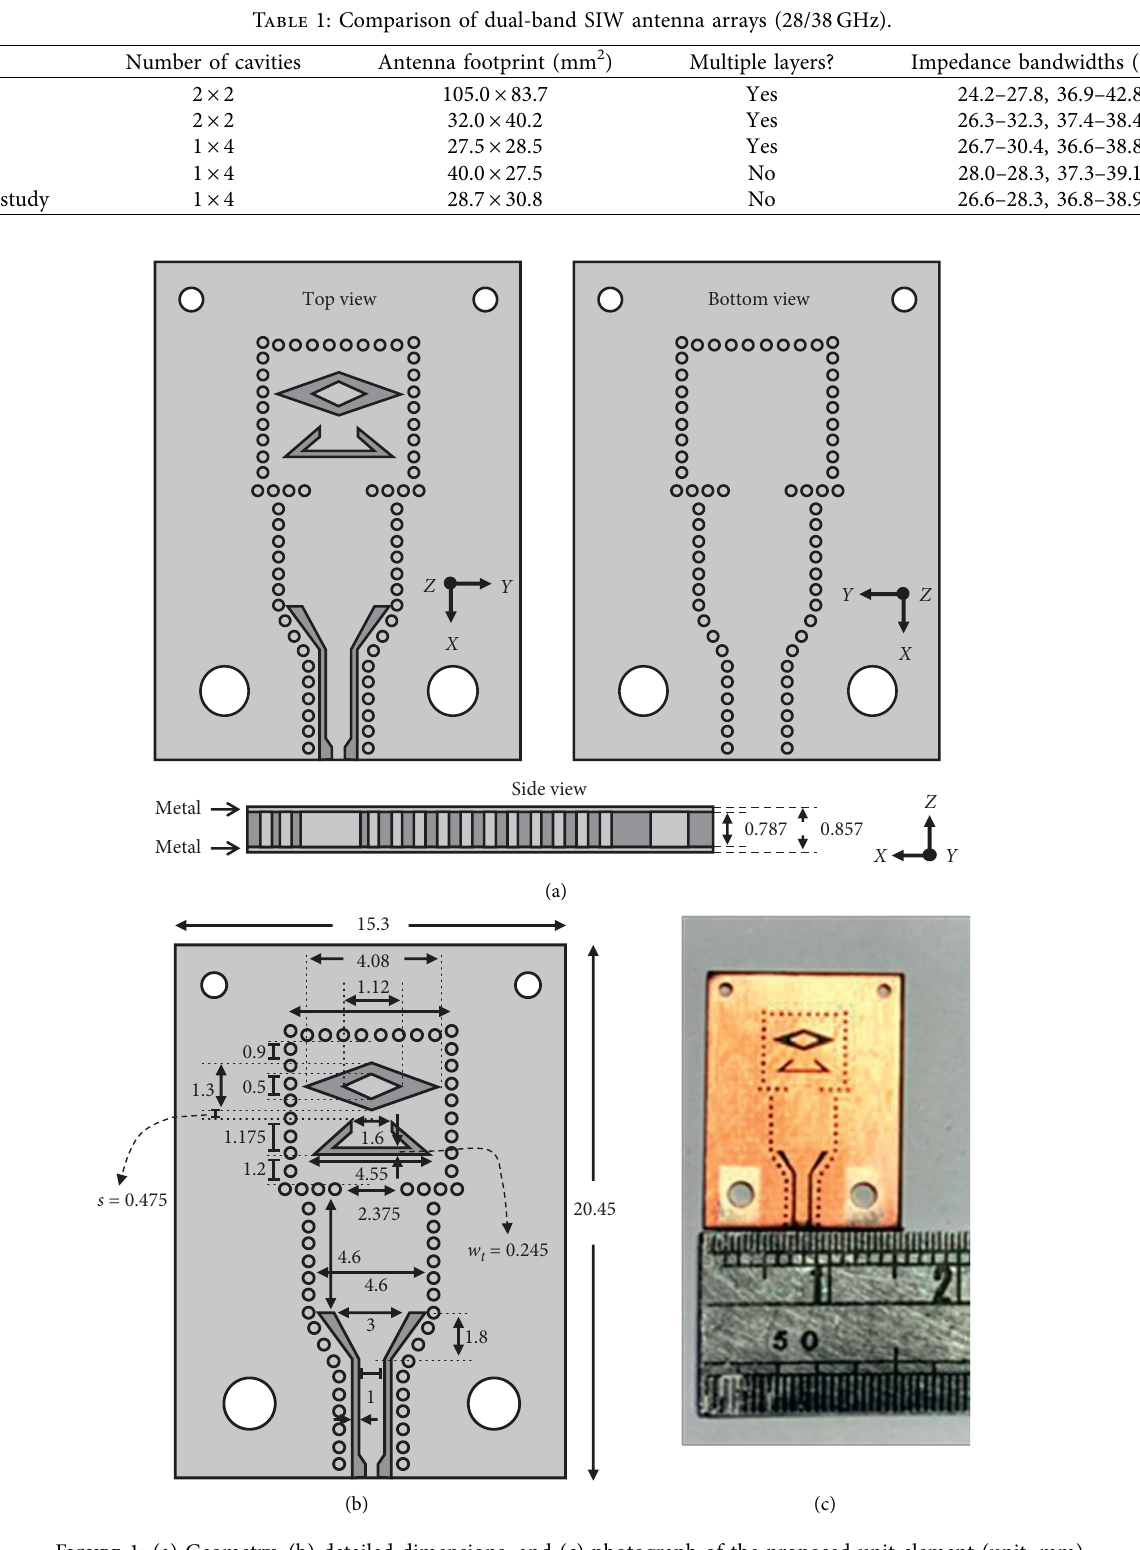
Figure 1: (a) Geometry, (b) detailed dimensions, and (c) photograph of the proposed unit element (unit: